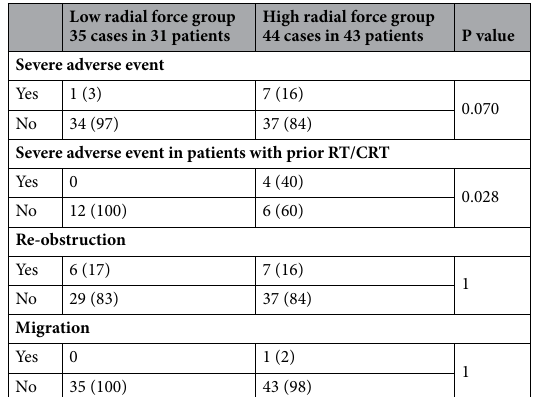
High radial force group 44 cases in 43 patients P